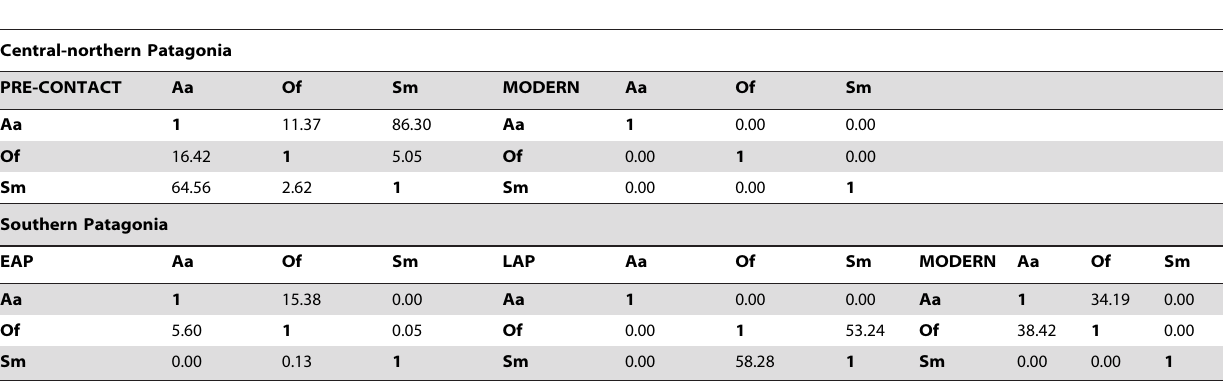
Table 6. Overlap as a percentage of standard ellipses corrected for small samples (SEA c ) of the three top predators described in the text.